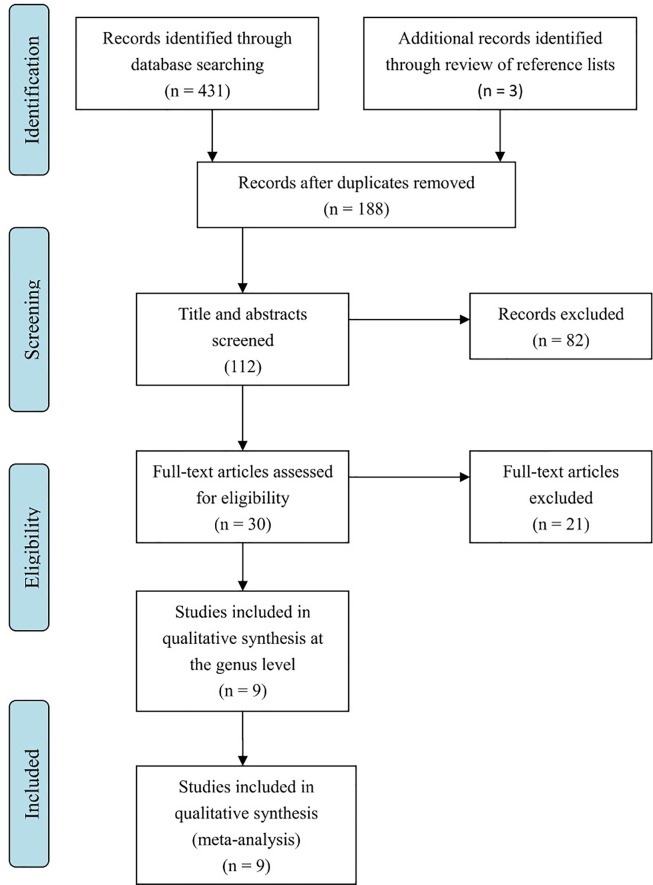
Flow diagram of study selection: article search strategy results.